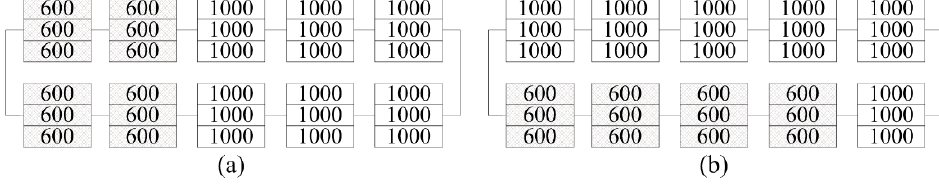
Figure 13. ( a ) Primary configuration C ori and ( b ) optimized configuration C EMPP (C opt ).